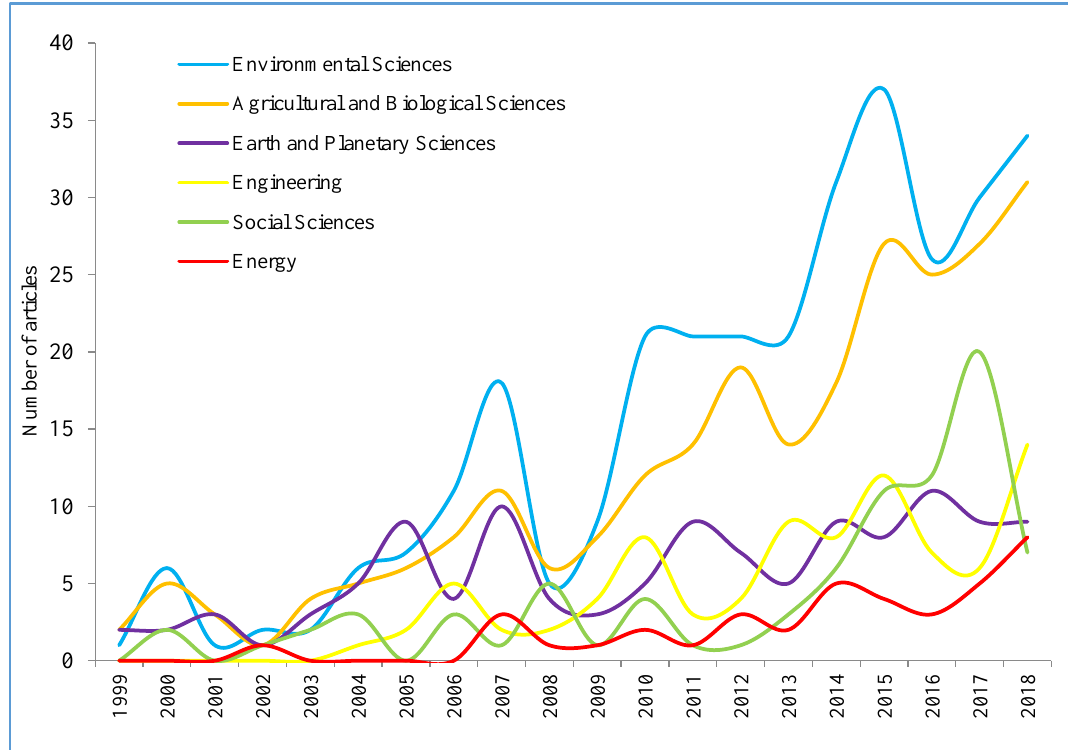
Figure 3. Comparative trends of subject categories related to RWHI research.